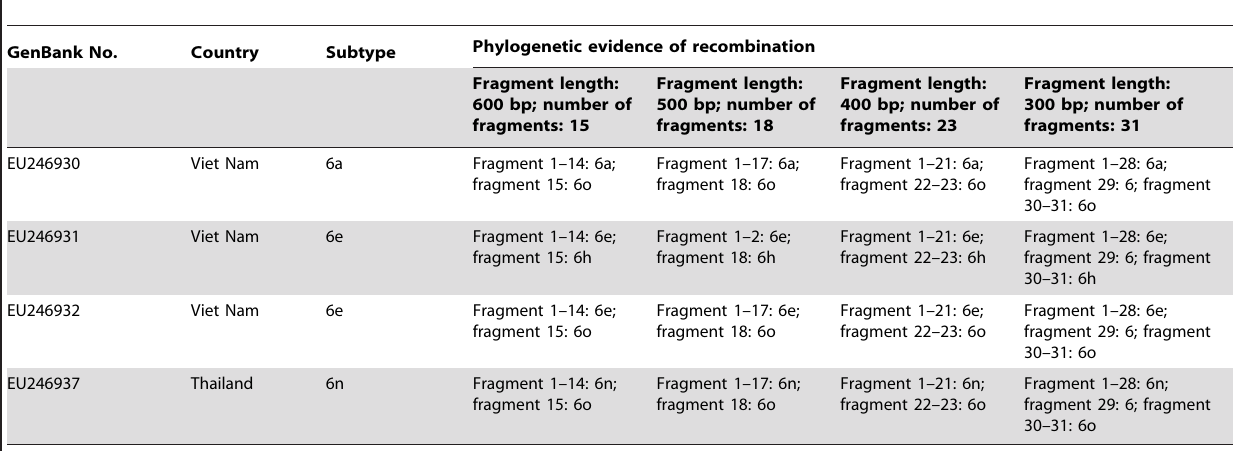
Table 1. Phylogenetic evidence of four novel inter-subtype recombination events.